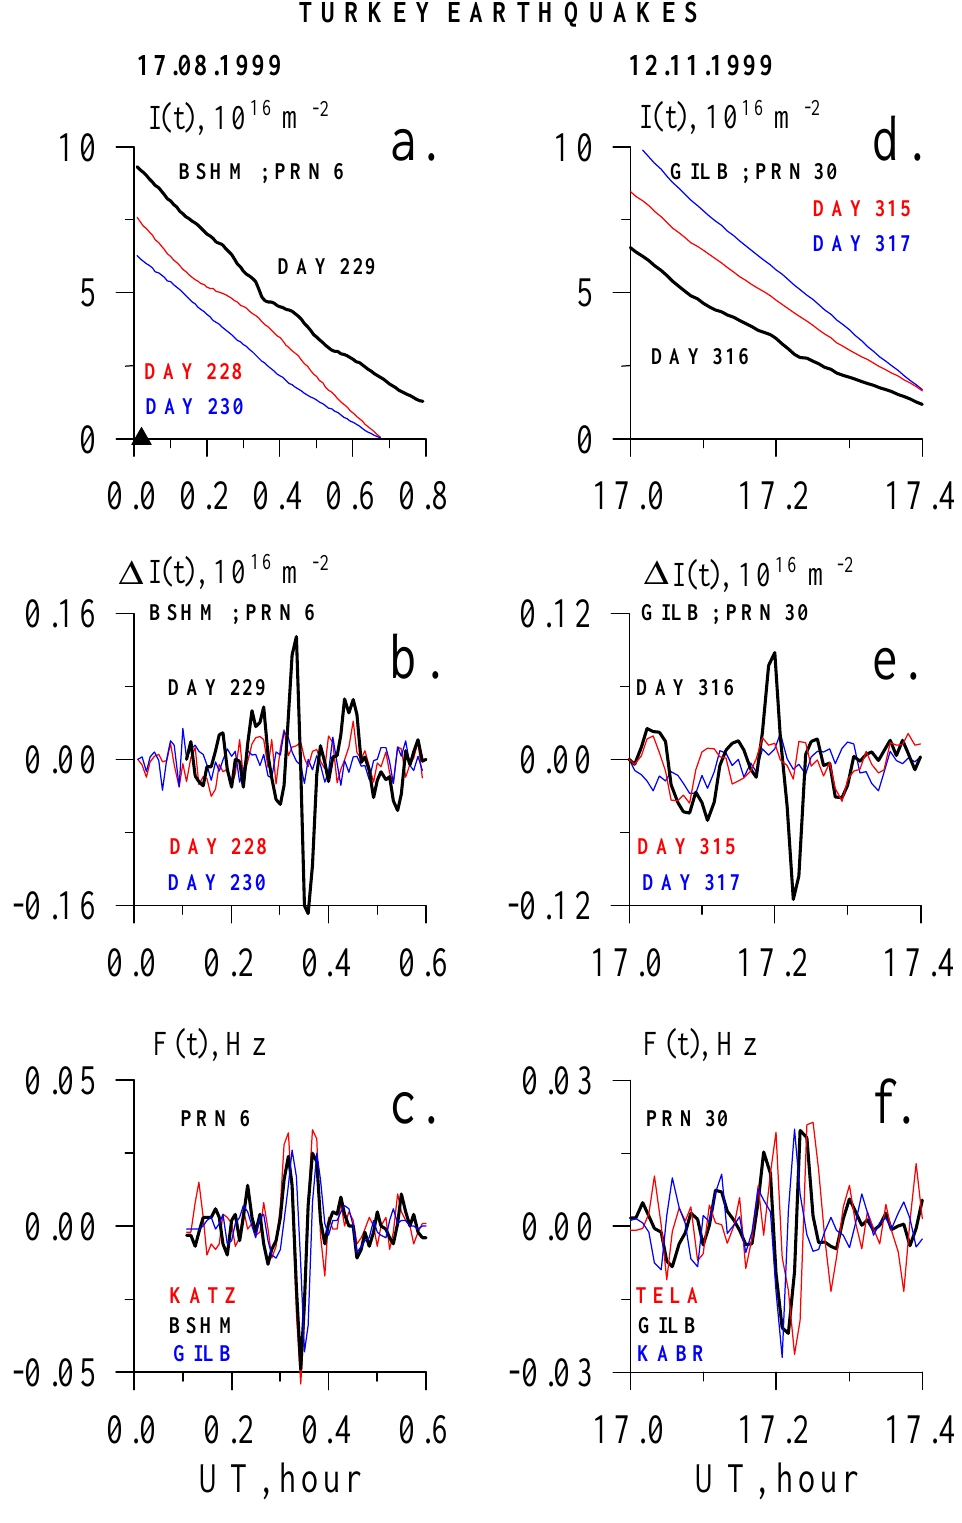
Fig. 2. Time dependencies of slant TEC I(t) at one of the three sites of the GPS-array in the area of the earthquakes on 17 August and 12 November 1999, on the day of earthquake (heavy curve), and one day before and one day after the event (thin curves) – panels (a,d) . Panels (b,e) – for the same days but the TEC variations 1I(t) with the linear trend removed and with a smoothing with a time window of 5 min; panels (c,f) – variations of the frequency Doppler shift F(t) ‘reduced’ to the sounding signal frequency of 136 MHz, for three sites of the arrays, days of earthquake. All panels show day numbers, GPS station names, and PRN numbers of the GPS